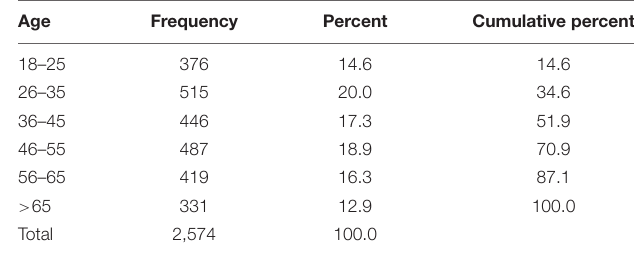
TABLE 1 | Participants by age